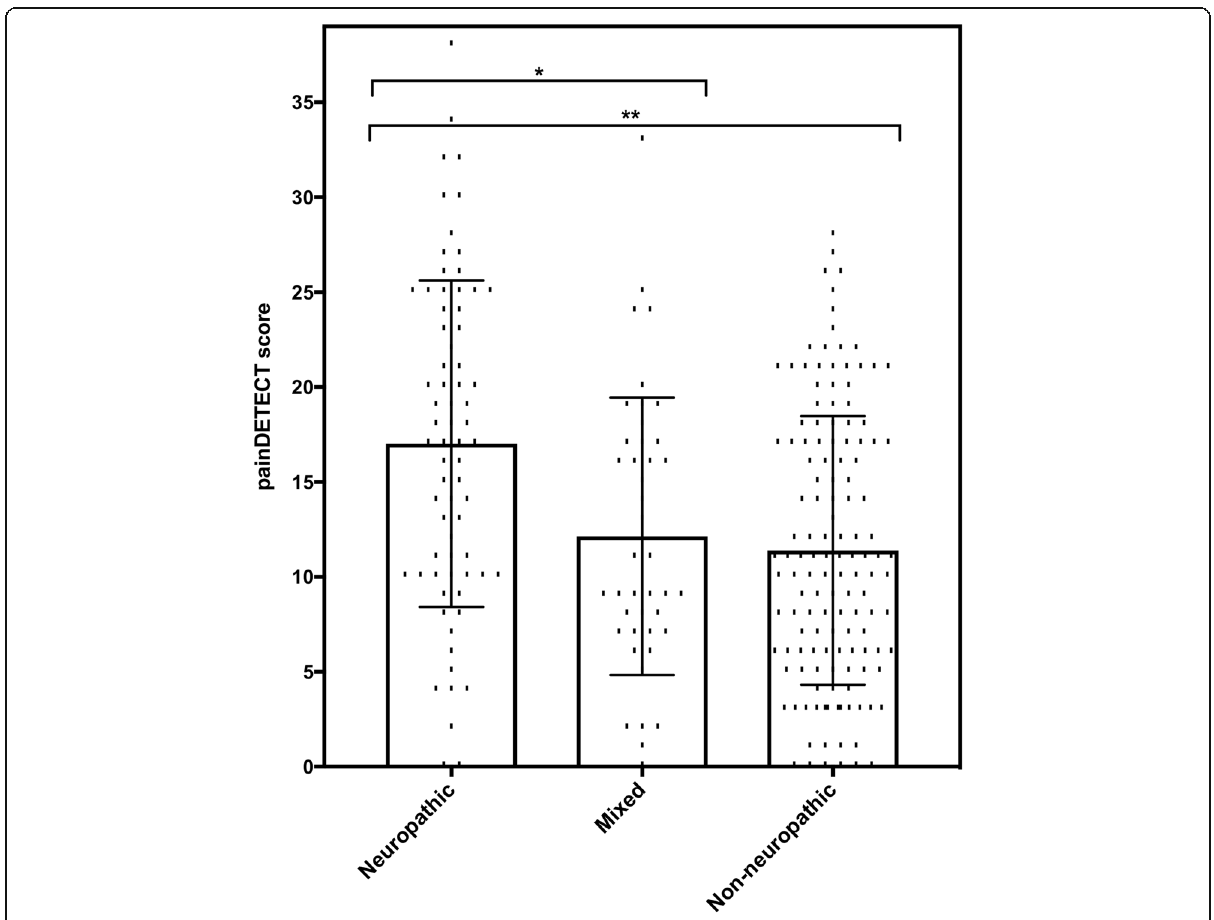
Fig. 3 Scatterplot representing median PD-Q scores for each type of pain in the OFP cohort. Error bars indicate IQR. Brackets and asterisks represent statistically significant differences between median PD-Q scores. *: p < 0.05, ** : p < 0.01